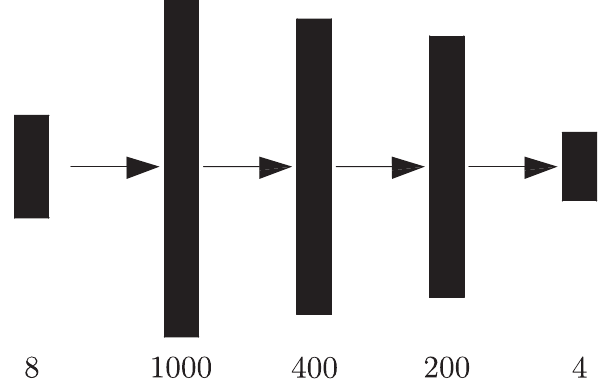
FIG. 5. Schematic plot of the neural network we use for learning the policy. We scaled the heights of the layers logarith- mically for visualization purposes. The numbers indicate the layer sizes, input and output dimensions.